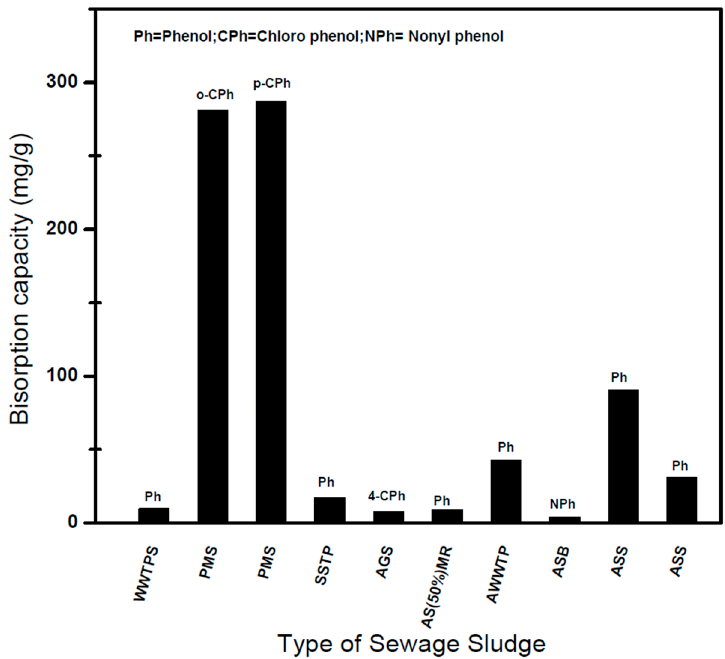
Figure 2. Dried sludge uptake capacity for phenolic compounds.